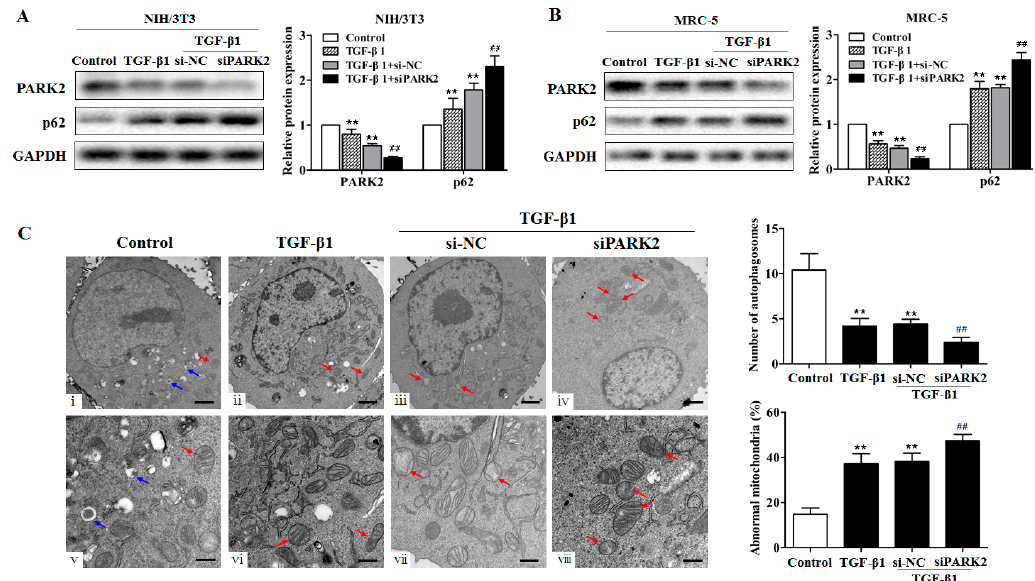
Figure 6. PARK2 knockdown suppresses mitophagy in fibroblasts. ( A , B ) Western blot and densitometric analysis of PARK2 and p62 expression in fibroblasts (NIH/3T3 and MRC-5) transfected with PARK2 siRNA (siPARK2) or its negative control (si-NC) then treated with 2 ng/mL TGF- β 1 for 48 h, with ** p < 0.01 vs. the control group and ## p < 0.01 vs. the TGF- β 1 plus si-NC group; ( C ) Transmission electron microscopy detection of mitochondrial structure and vacuoles of fibroblasts (NIH/3T3) transfected with siPARK2 or si-NC then treated with 2 ng/mL TGF- β 1 for 48 h. Blue arrows indicate autophagic vacuoles. Red arrows indicate abnormal mitochondria. Quantification of autophagosomes and percentage of abnormal mitochondria (swollen with an irregular shape and disorganized cristae) from electron microscopy images were performed (five cells each group), with ** p < 0.01 vs. the control group and ## p < 0.01 vs. the TGF- β 1 plus si-NC group. Scale bars, 1 µm (upper panels) and 500 nm (lower panels). All data are expressed as the mean ± SD of at least three independent experiments.